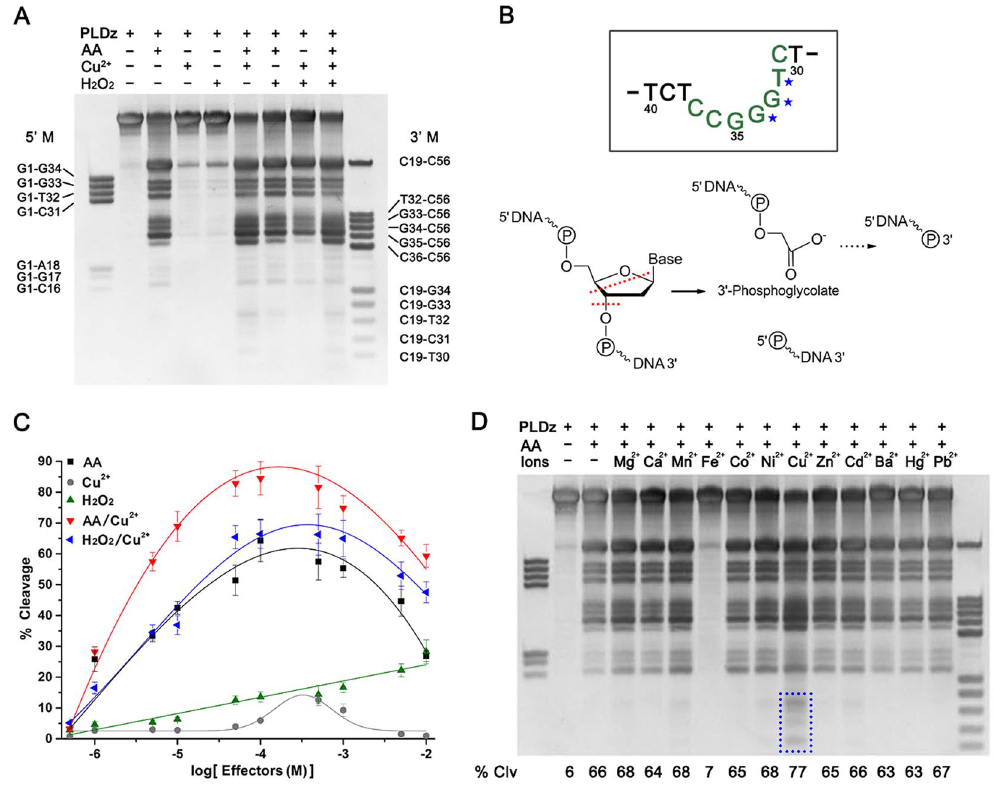
Figure 2. PLDz catalysis in the presence of different cofactors. ( A ) Effects of general cofactors on PLDz- catalyzed cleavage. PLDz (1 μ M) was incubated with 100 μ M cofactors at 23 °C for 2 hr in a mixture containing 50 mM Tris-HCl (7.0) and 300 mM NaCl. Lanes designated 5 ′ M and 3 ′ M were synthetic DNAs of different lengths as indicated, each with a sequence that corresponds to the 5 ′ and 3 ′ terminus (including middle fragments) of the PLDz, respectively (Supplementary Table 1). Letter-numbers indicate the lengths of these marker DNAs. Reaction products were separated by denaturing (7 M urea) 20% PAGE and were visualized by GelRed dye staining. ( B ) Oxidative cleavage of the target site deoxynucleotide. The DNA in the grey square represents the part structure of PLDz. The blue asterisks indicate the minor sites of DNA cleavage. The red dashed lines depict the possible locations of deoxynucleoside cleavage fragmentation. Dashed arrow indicates the possible conversion of phosphoglycolate into phosphate. ( C ) Concentration-dependent induction of PLDz function by cofactors. ( D ) Analysis of the function of PLDz with divalent metal ions in the presence of AA. The dashed box represents small cleavage fragments of PLDz including c19-c31, c19-t32 and c19-g33 (Supplementary Figure 1), which appeared more clearly with increased levels of exposure (Supplementary Figure 2) Reactions were conducted as described in part A. Note that only Fe 2 + inhibited PLDz activity. Cropped gels are used in Fig. 2A and D, their full-length gels are presented in Supplementary Figure